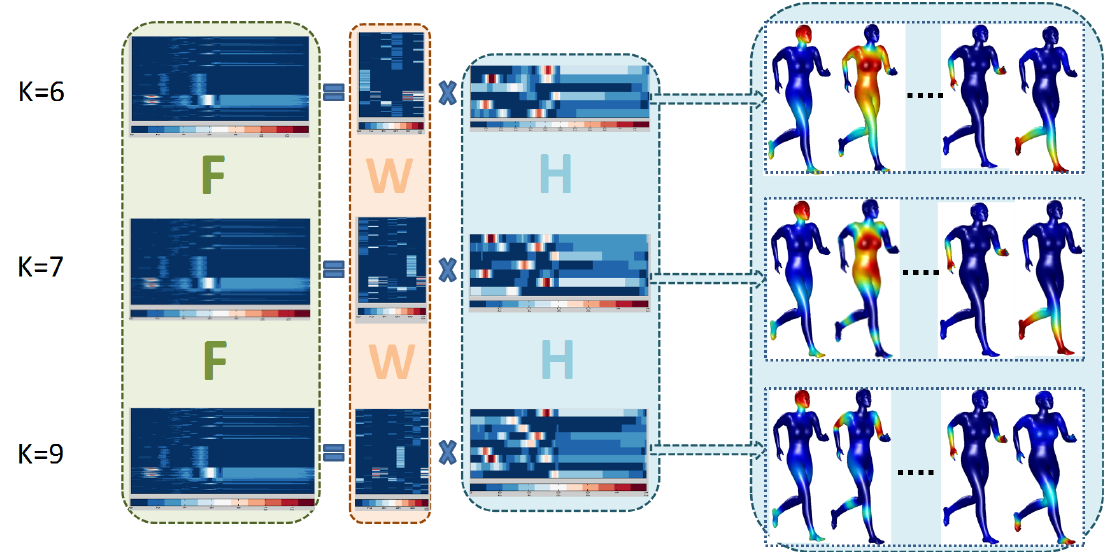
Figure 9. Visualization of the hidden variables by conducting SAC-NMF with different settings of the base